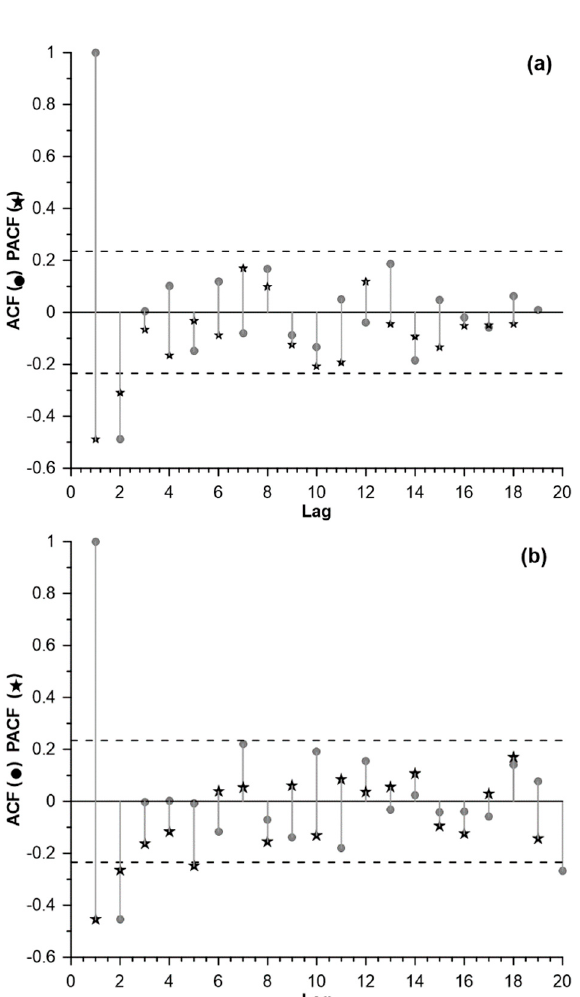
Figure 4. ACF (circles) and PACF (stars) values ( a ) for the differential annual earthquake number and ( b ) for the differential annual maximum magnitude.